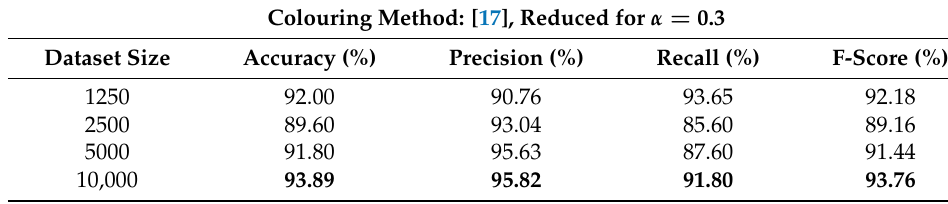
Table 6. Performance metrics for [17], processed with α = 0.3.